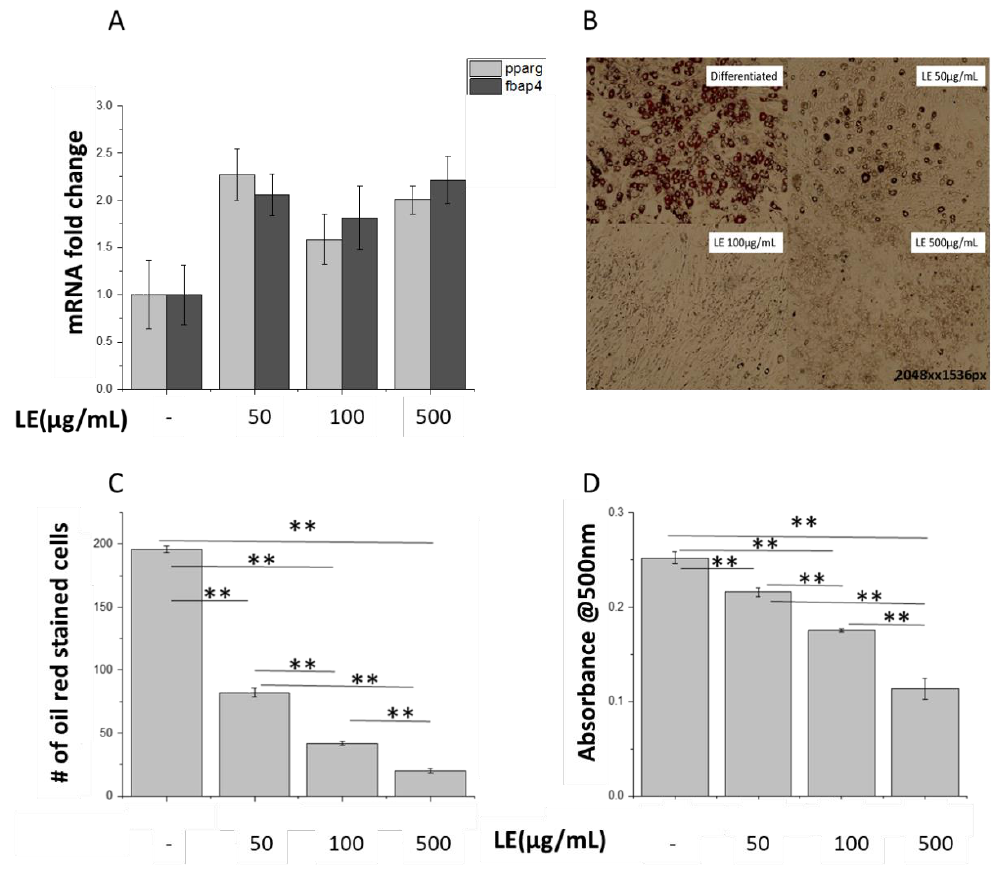
Figure 2. Lemon extract (LE) decreases lipid droplets in 3T3-L1 adipocytes. ( A ) PPARγ and FABP4 mRNA expression levels were quantified in adipocytes treated with and without LE (100 µg/mL) for 8 days. n = 3. ( B ) Lipids were visualized using Oil Red staining. Images are representative of 3 experiments. ( C ) Staining was quantified using ImageJ by calculating number of oil red stained cells in the section shown in ( B ), ** significant at p = 0.01. ( D ) Quantified oil red stain in treated and untreated adipocytes, ** significant at p = 0.01.